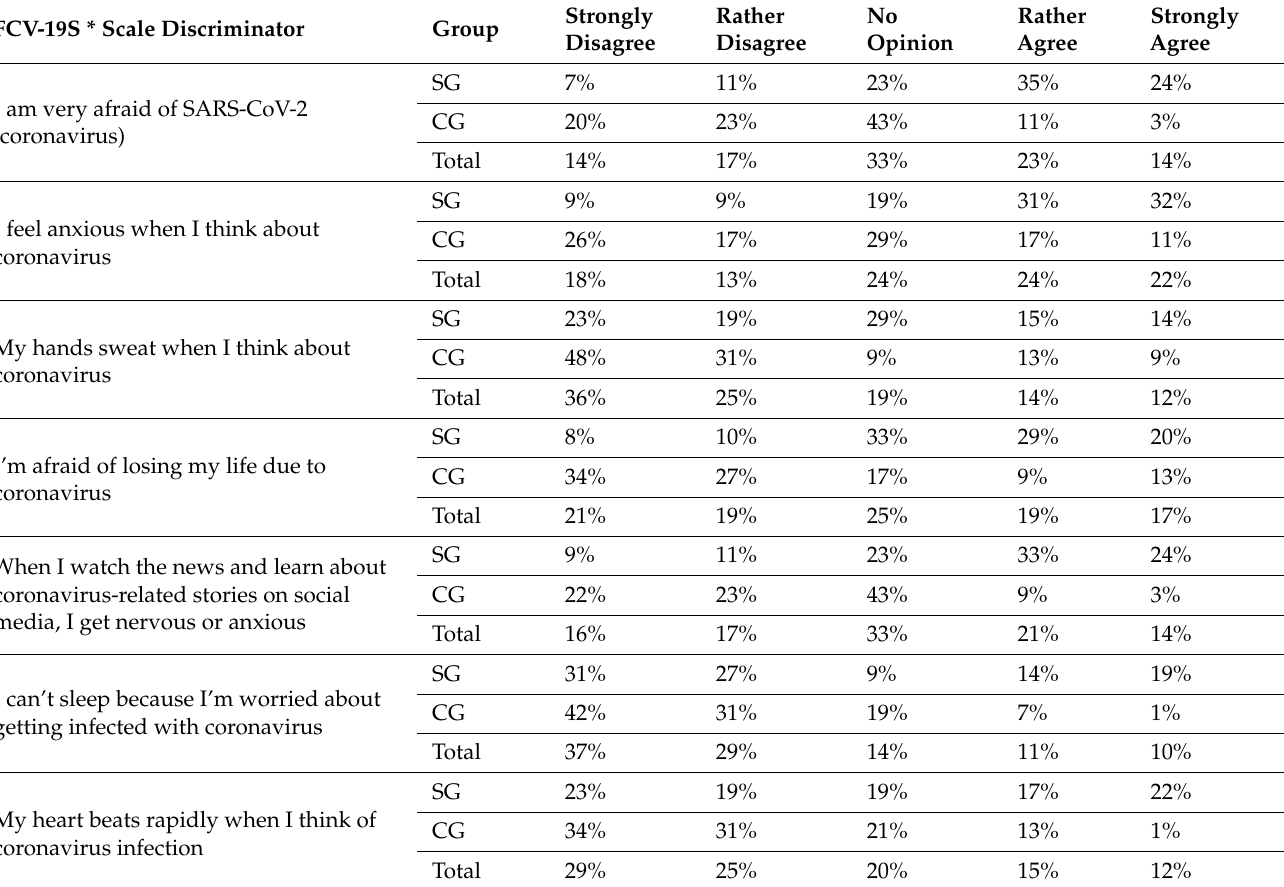
Table 2. FCV-19S scale responses in the oncology patients (SG) and control group (CG) (N = 600). FCV-19S * Scale